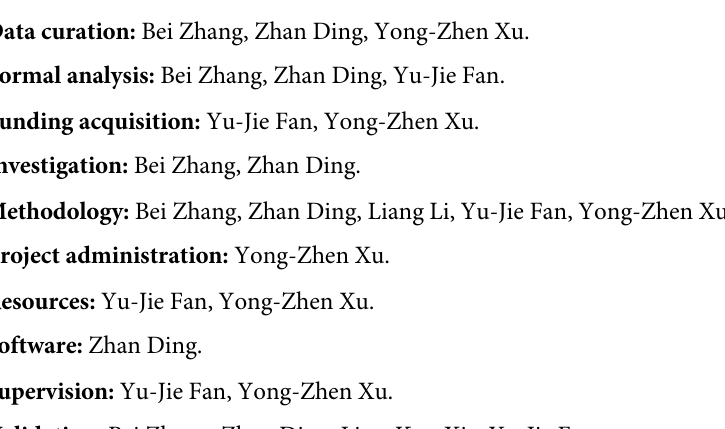
S1 Table. Summary of SF3B1 mutations in human cancers. S2 Table. RNA-seq samples and reads in this study. S3 Table. Significantly changed gene expression in the sf3b1 mutants. S4 Table. Significantly changed AS events in the sf3b1 mutants. S5 Table. Significantly changed AS events in the muscle and neural-related genes in the sf3b1 mutants. S6 Table. Significantly changed USS in the sf3b1 mutants. S7 Table. Primers used in this